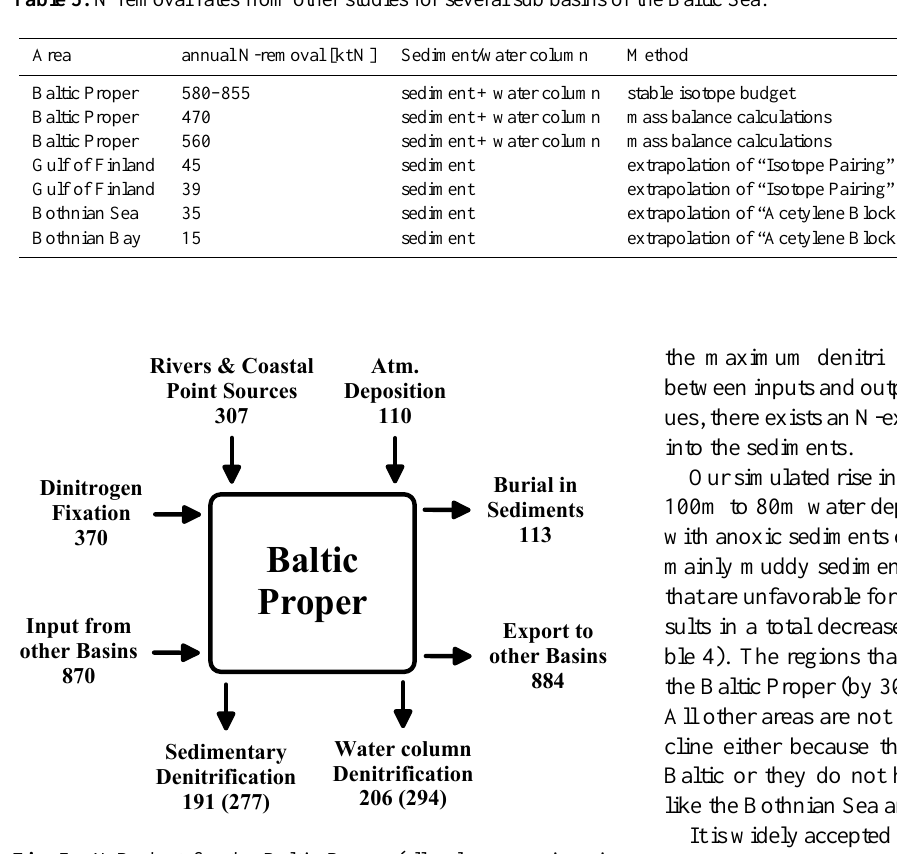
Fig. 5. N-Budget for the Baltic Proper (all values are given in Figure 5: N-Budget for the Baltic Proper (all values are given in kt N a -1 ). Mean and ktNa − 1 ). Mean and maximum removal rates (in parentheses) by maximum removal rates (in parentheses) by denitrification are presented. denitrification are